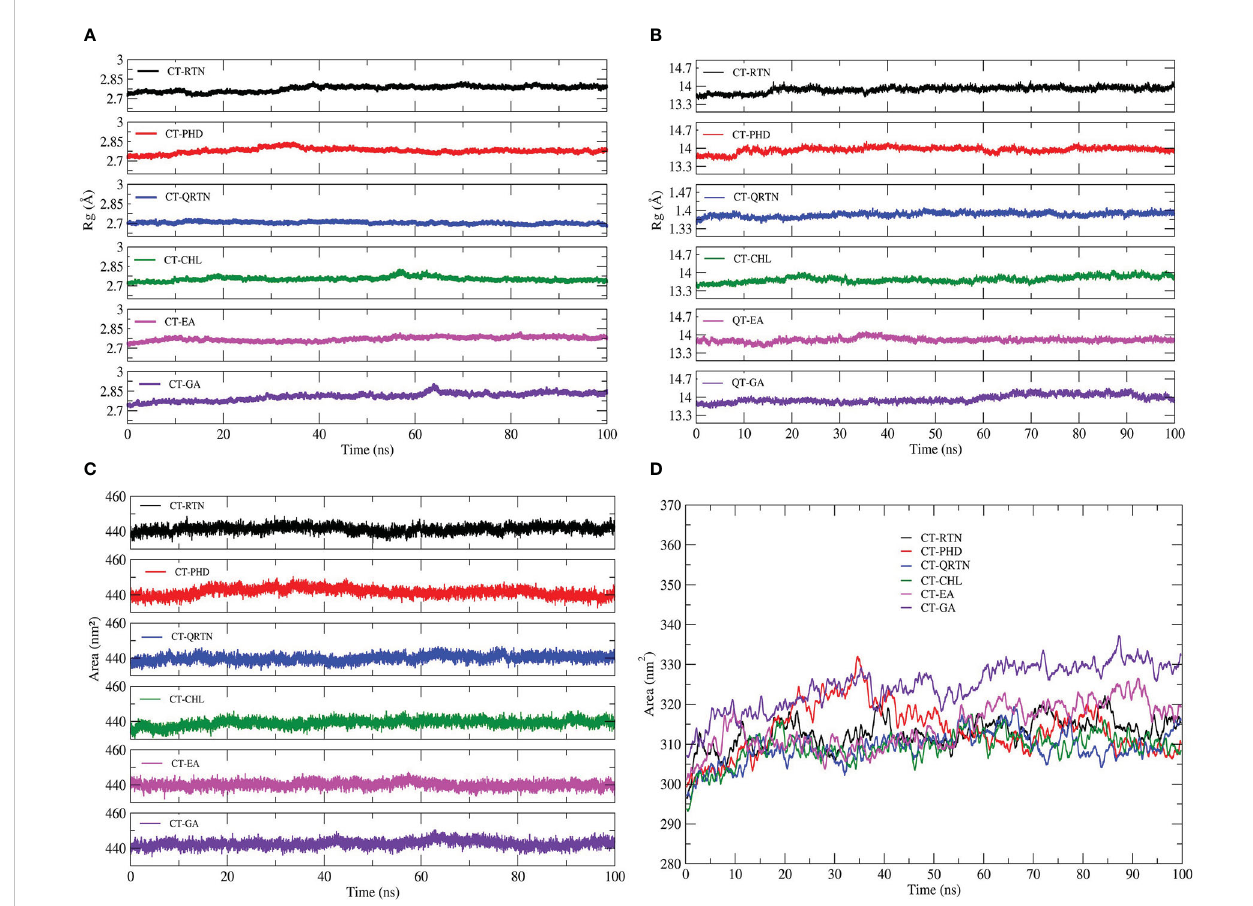
FIGURE 5 The compactness of the CT-complexes and chain F GM1 binding pocket is shown as (A) and (B) respectively. The hydrophobicity of CT-complexes is also quanti fi ed by analysing solvent accessible surface area for the entire CT-complex (C) as well as chain F (D) .